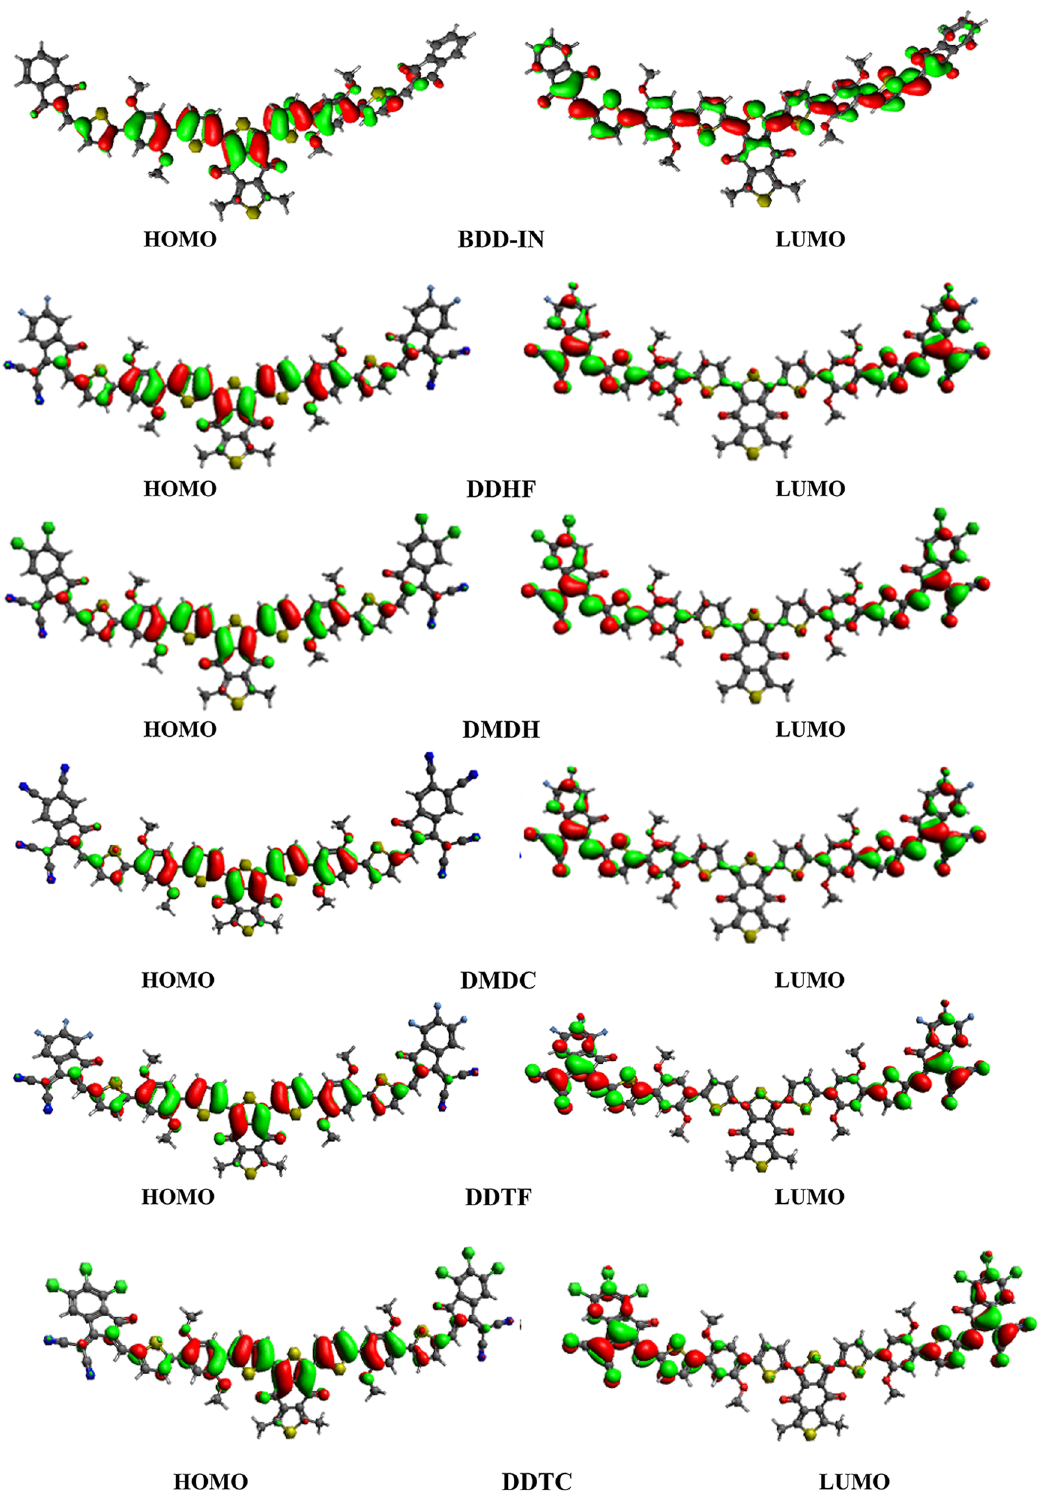
Figure 4. Pictographic representation of FMOs for reference and designed compounds. The pictures are drawn with the help of Avogadro software, Version 1.2.0. (http:// avoga dro. cc/). All out put files of entitled compounds were accomplished by Gaussian 09 version D.01 (https:// gauss ian. com/ g09ci